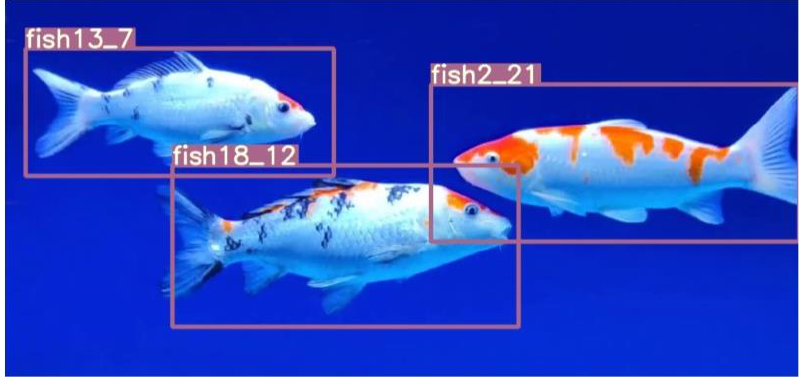
Figure 15. Sample diagram of the final recognition result.